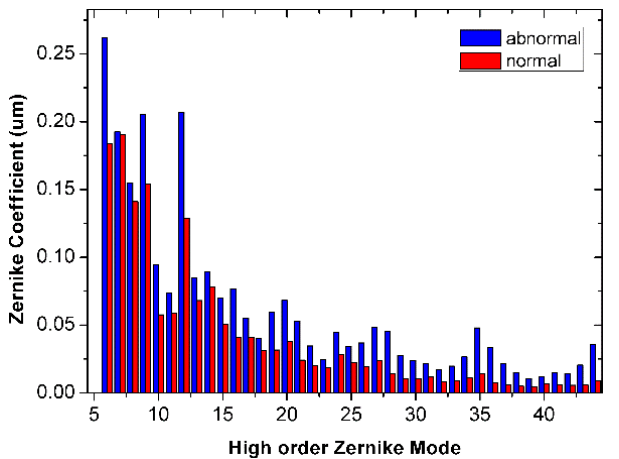
Fig. 2. Mean absolute values of Zernike coe±cients from the 3rd to the 8th order in normal group and abnormal group across a 6.0-mm pupil.